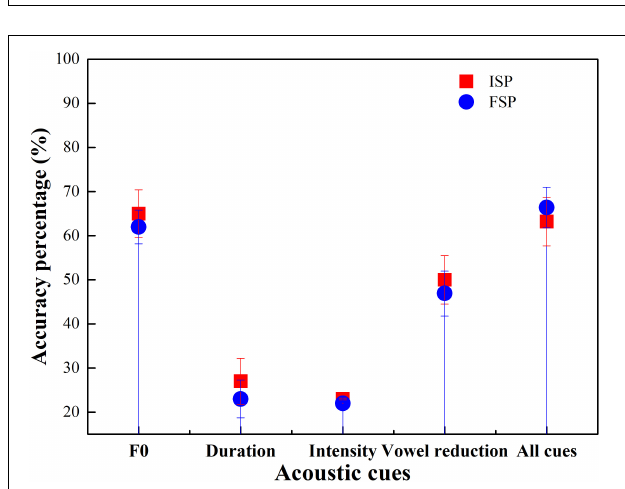
FIGURE 5 | Accuracy for ISP and FSP with the BJ group.